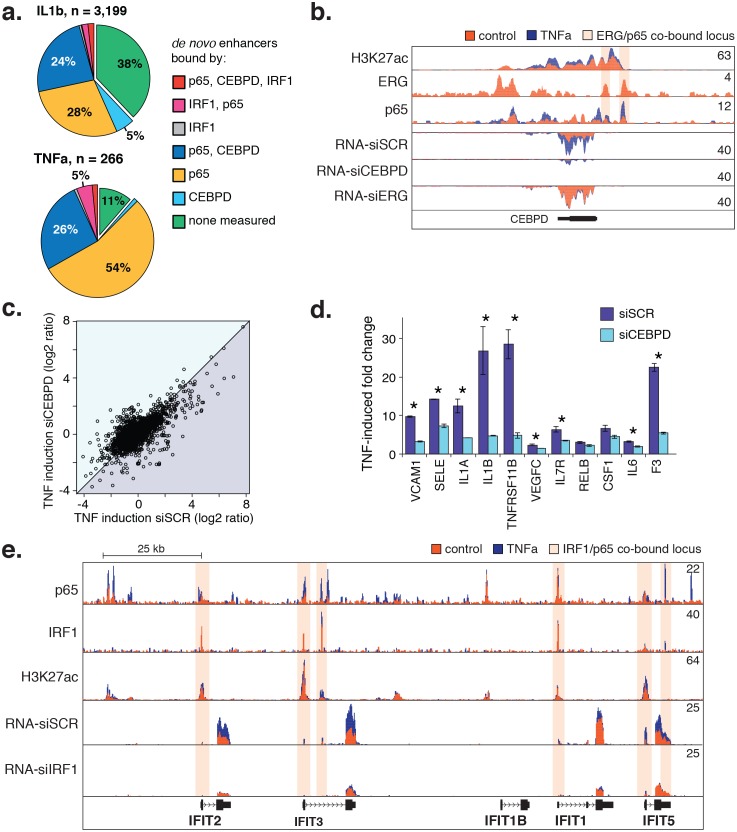
CEBPD and IRF1 knockdown effect on gene expression response to TNFα.(a) Binding of p65, CEBPD, and IRF1 was measured by ChIP-seq and is shown at de novo enhancers elicited by IL1β (e) and TNFα (f). Factor binding was measured by CHIP-seq upon 4-hr cytokine treatment, with binding of CEBPD measured after IL1β only. (b) Factor binding, H3K27ac, and mRNA expression is shown at the CEBPD locus in control-treated and TNFα-treated HAECs. CEBPD mRNA is shown in the bottom three tracks as a function of control knockdown (siSCR), CEBPD knockdown, and ERG knockdown. (c) A global view of mRNA responses to TNFα as a function of CEBPD knockdown (y-axis) compared to control (x-axis); mean ± S.D. (d) The response to TNFα is shown for molecules of interest in control (siSCR) and CEBPD knockdown HAECs. (e) The IFIT locus, highlighting elements co-bound by IRF1 and NFκB (p65). More related data in Figure 6—figure supplement 1.DOI:
http://dx.doi.org/10.7554/eLife.22536.02310.7554/eLife.22536.024Figure 6—source data 1.Transcripts up-regulated by more than twofold by CEBPD knockdown in untreated HAECs compared to scrambled control.Differential expression performed in DEseq.